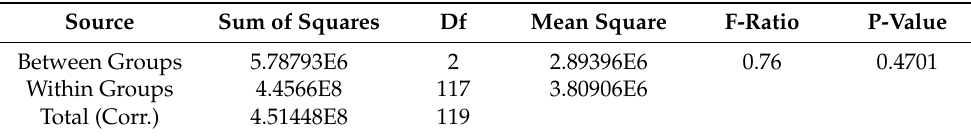
Table 6. ANOVA table for Col_3 Weight loss by Col_2 thickness. Source Sum of Squares